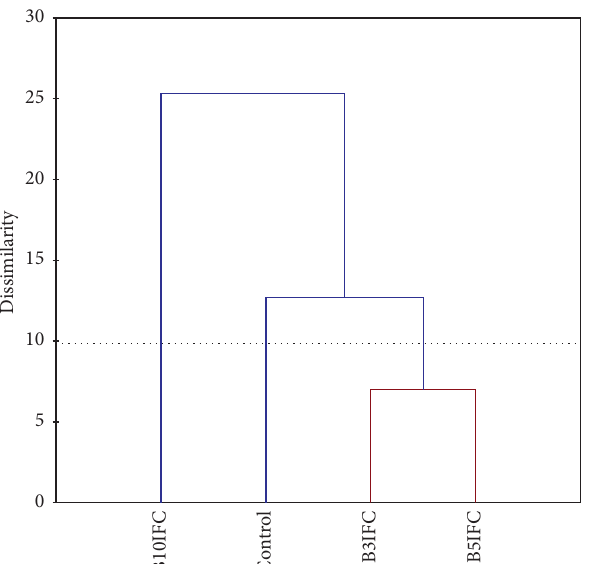
Figure 4: Agglomerative hierarchical cluster analysis (HCA) of physicochemical analysis (pH and aw), instrument color (a ∗ , b ∗ , and L ∗ ) and texture parameters (chewiness, hardness, elasticity, cohesiveness, and adhesiveness), and sensory characteristics (color, flavor, appearance, texture, and overall acceptability) of untreated (control) and different treated (B3IFC, B5IFC, and B10IFC) meat